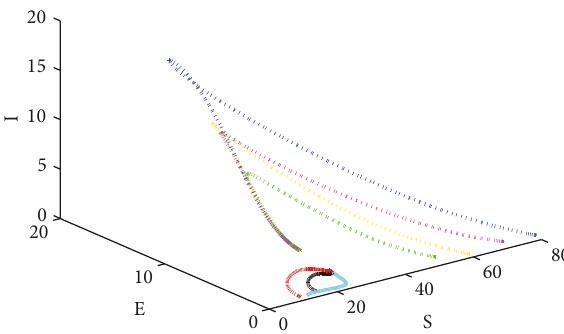
Figure 6: The tendency of 𝑆 , 𝐸 , and 𝐼 .